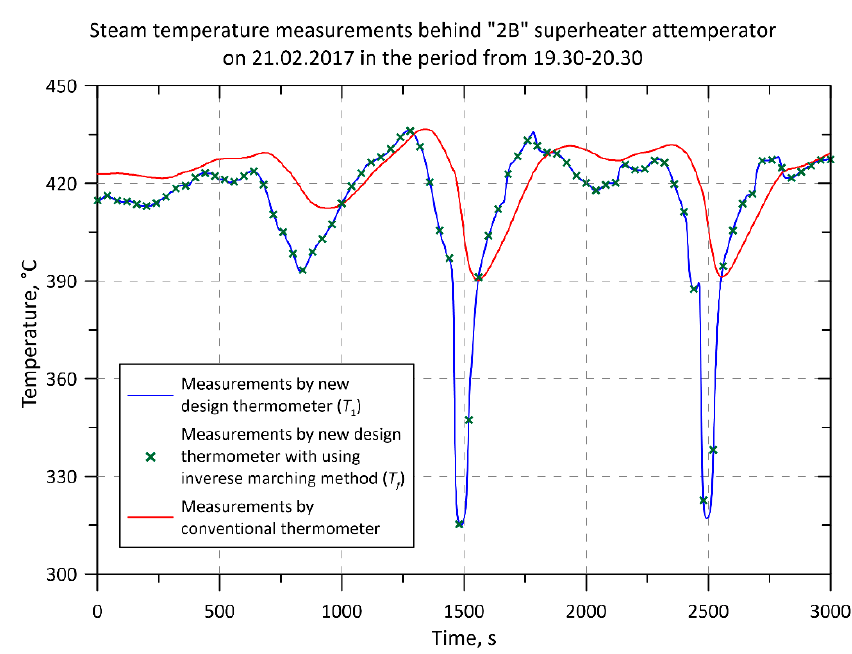
Figure 7. Comparison of superheated steam temperature downstream of the second superheater attemperator measured on side “B” in the K11 boiler by conventional and new design thermometers.